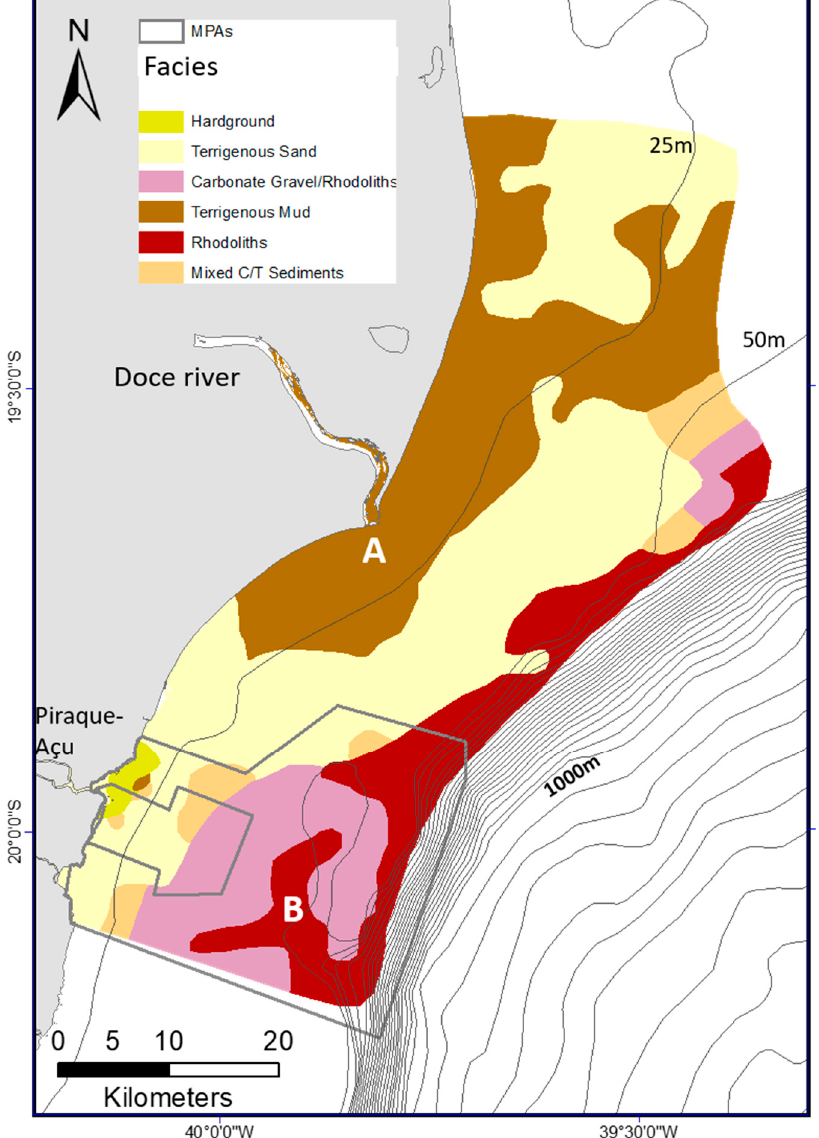
Figure 4. Morpho-sedimentary Facies distribution. ( A ) and ( B ) are sonographic and seabed images locations shown in Figure 5. The dataset used to produce this map is shown in Figure 1, including the full side scan sonar and sub-bottom profiler coverage. Depth contour intervals: 25 m from 0 to 100 m, 50 m from 100 to 1000 m, and 100 m from 1000 to 2000 m.